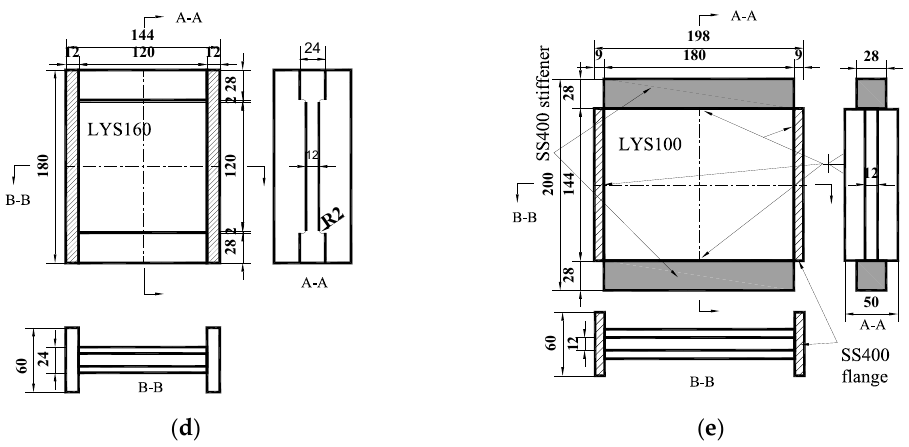
Figure 2. Damper shape: ( a ) SPD100-50; ( b ) SPD100-28; ( c ) SPD100-10; ( d ) SPD160-28; and ( e ) SPD100-rib (mm).